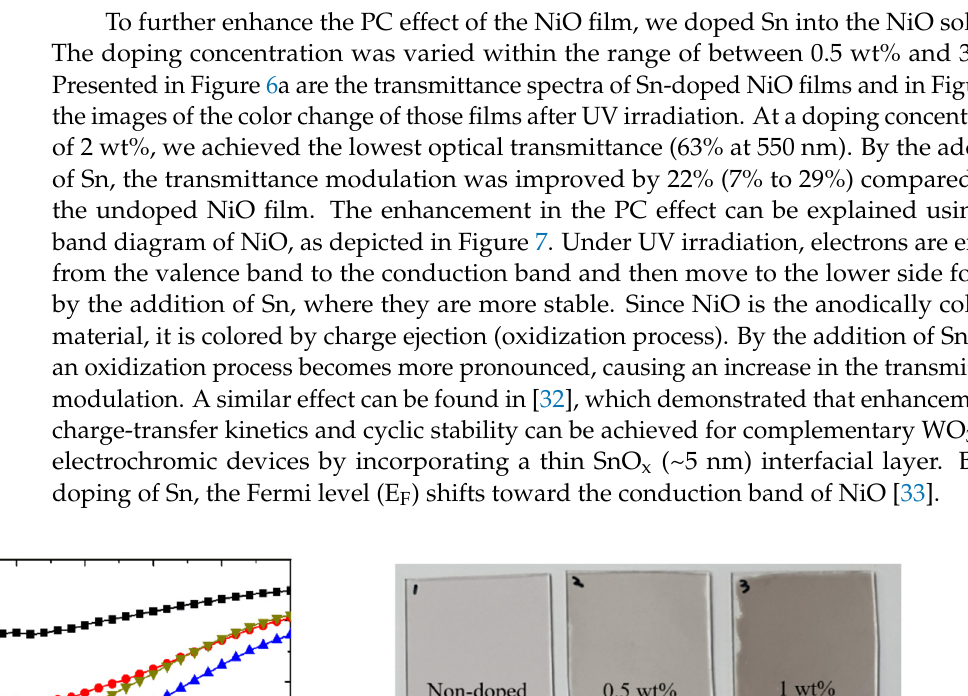
Figure 5. SEM images of undoped NiO film ( a ) before and ( b ) after UV/O 3 treatment.